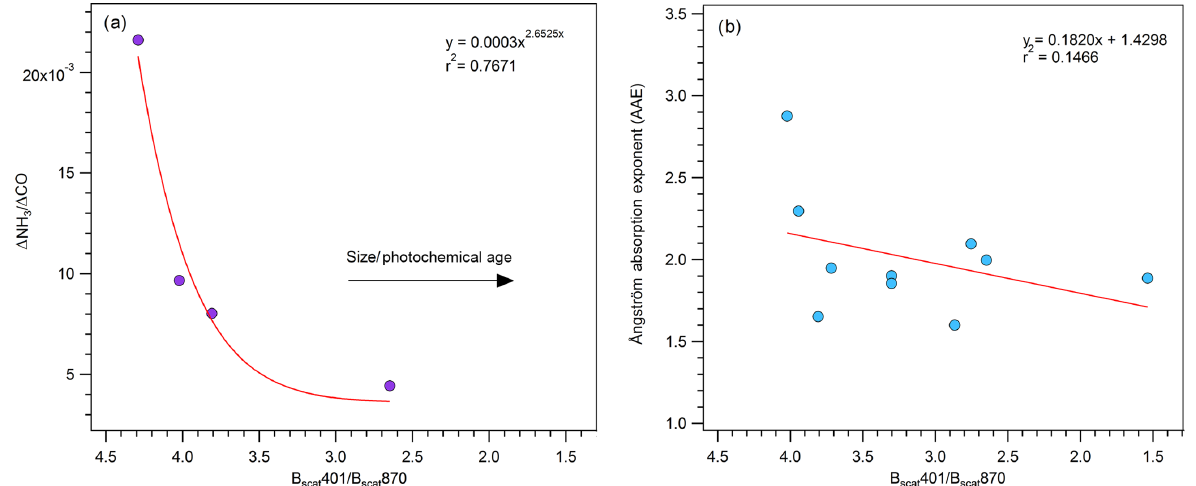
Figure 4. (a) Plot of the peak-integrated (cid:49) NH 3 /(cid:49) CO ratio versus our size and age proxy (401 scattering/870 scattering) for smoke impacts that have an (cid:49) NH 3 /(cid:49) CO ratio. (b) Plot of the peak-integrated absorption Ångström exponent versus our size and age proxy (401 scatter- ing/870 scattering) when both PAXs were